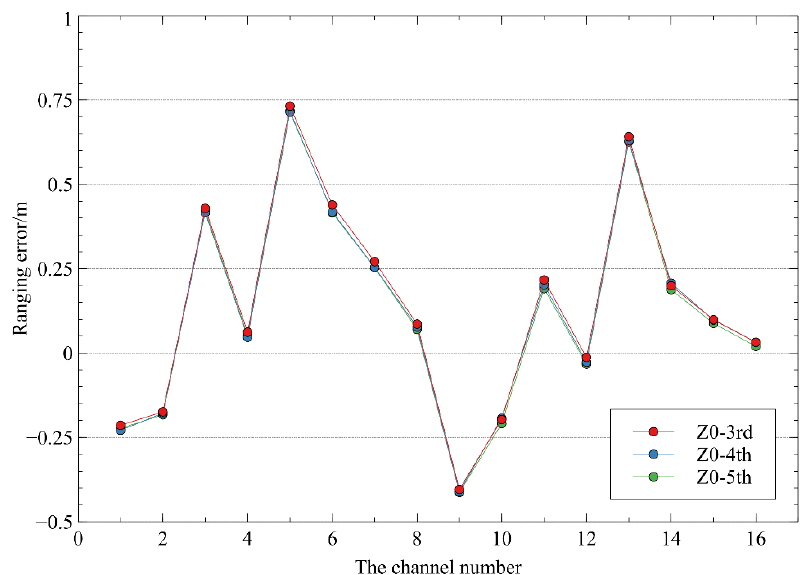
Figure 4. Calibration results of the 16-channel range error for CE-3’s TDI. The horizontal axis is the laser beam channel index number of TDI, and the vertical axis is the calibration result of the laser beam ranging error. Three sets of scanning data with zero degree elevation angle were used as input data for geometric calibration. Through comparison, it can be seen that the ranging errors obtained from three geometric calibrations are very consistent.